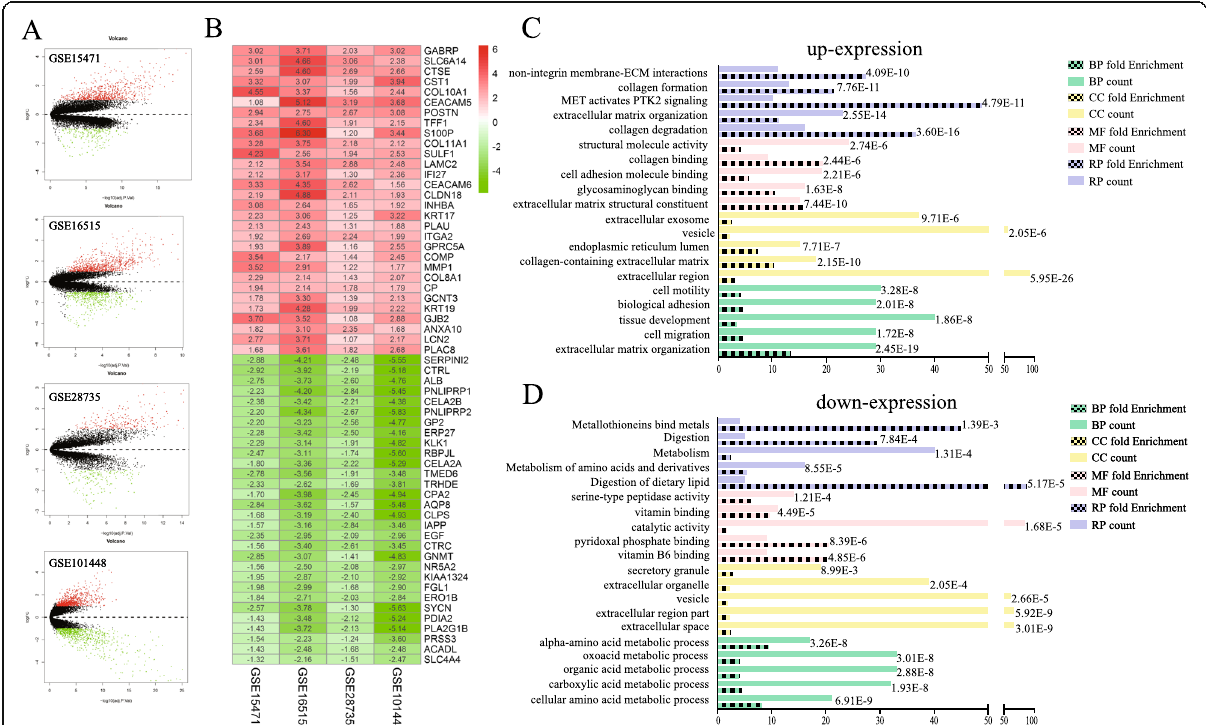
Fig. 2 Identification of differentially expressed genes and their enrichment analysis. a The volcano plots of gene chips. b Heatmap displayed the log 2 (Fold change) of top 30 high expression genes and 30 low expression genes selected by Robust Rank Aggreg (RRA) methods from 4 independent gene chips. Each row represented the same mRNA from different gene chips and each column represented the same chip. The log 2 (Fold change) tendency of each mRNA was displayed in shade of red or green and the values of log 2 (Fold change) were marked within each box. Red represented the fold change of up- expressed genes and green represented down-expressed genes, respectively, compared to para-carcinoma tissues. c-d Gene ontology (GO) enrichment analysis and Reactome pathway enrichment analysis of high expression genes ( c ) and low expression genes ( d ). The vertical axis represented GO term or pathway, and the horizontal axis represented count of genes or fold enrichment. The column with black patches represented fold enrichment. The value of false discovery rate was shown at the end of each column. BP, biological process; CC, cellular component; MF, molecular function; RP, Reactome